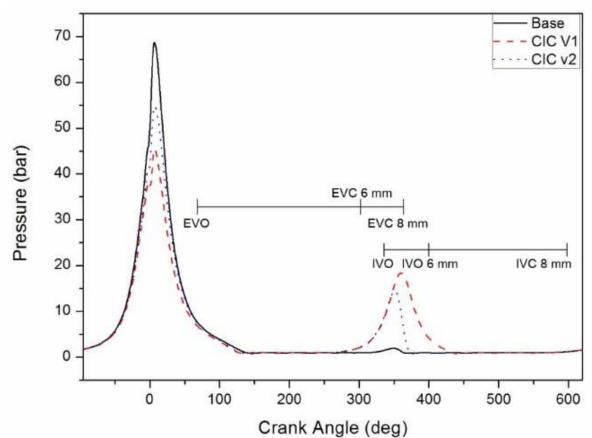
Figure 7. Pressure variation for three different recompression strategies.